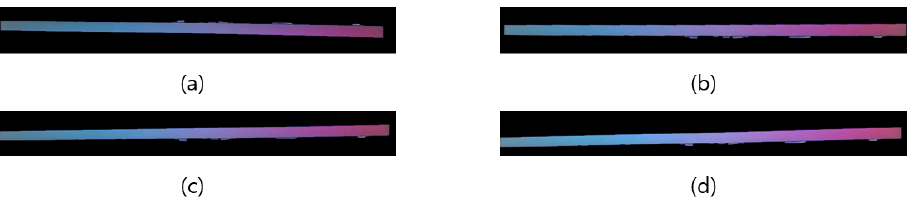
Figure 8. Synthetic data using data augmentation techniques such as enlargement/reduction, rotation, position transformation, and vertical inversion. ( a ) Original data, ( b – d ) Synthetic data.